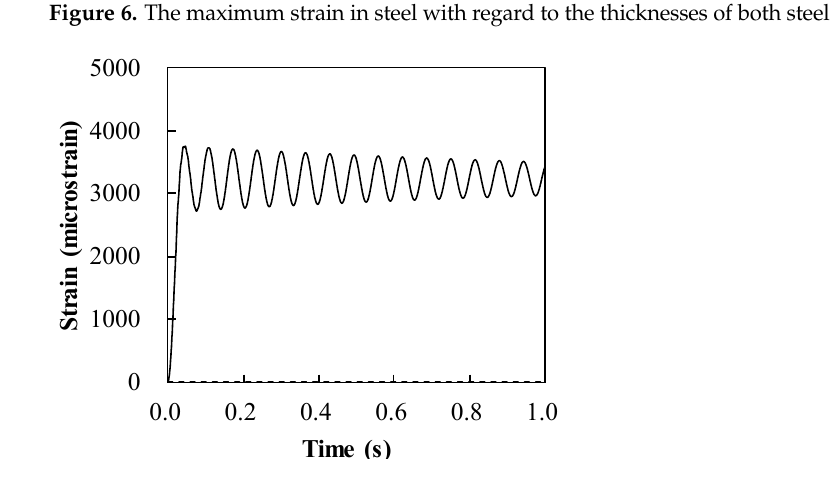
Figure 8. The maximum stress in CFRP with regard to the thicknesses of both steel slab and CFRP pipe.